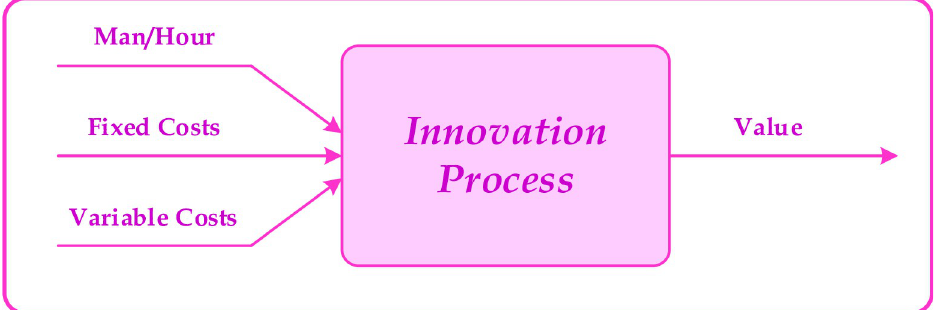
Fig 1. Product development process